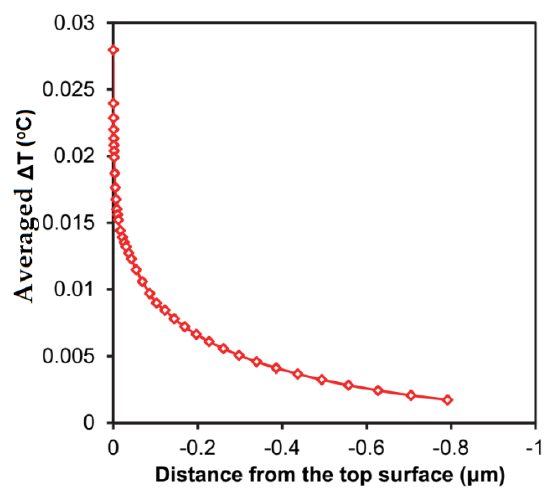
Figure 8. A typical cylindrical temperature increase (°C) contour profile of the AlN thin-film/Si substrate system. The thickness of the thin film is 2 μm.